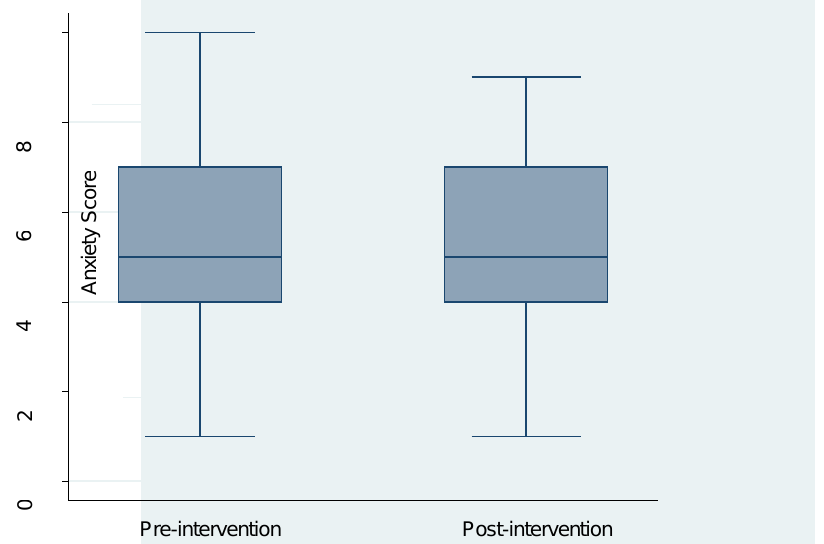
Figure 4. Anxiety score by study period.